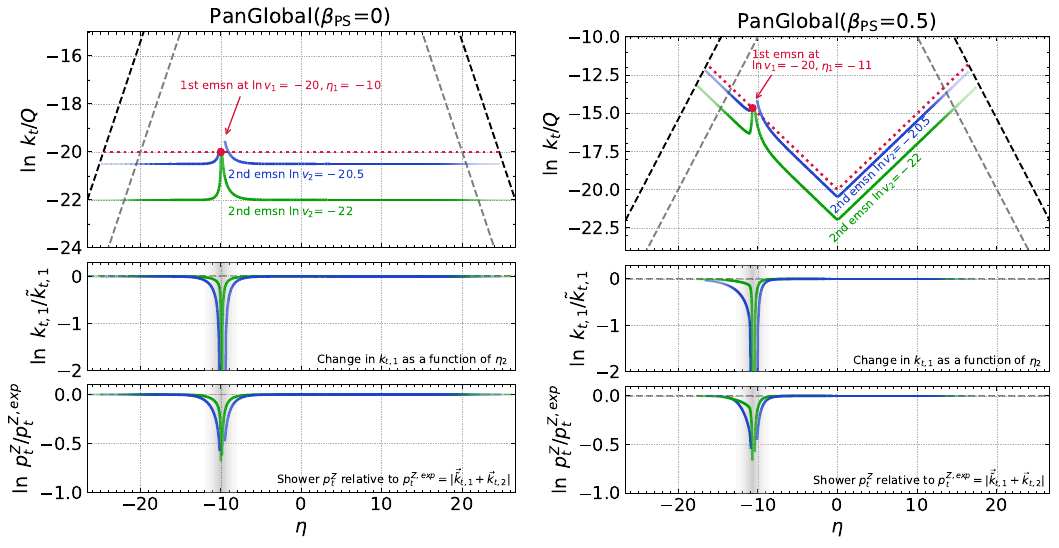
Figure 3. Same as figure 2, but for PanGlobal with β ps = 0 (left) and β ps = 0 . 5